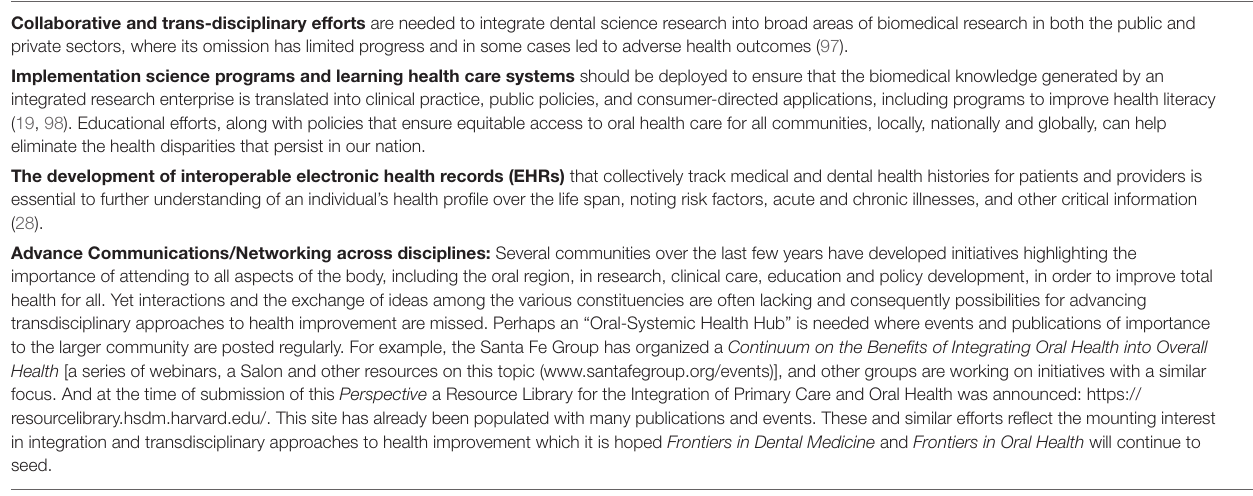
TABLE 2 | Approaches toward achieving integration of oral health within the context of total health. Collaborative and trans-disciplinary efforts are needed to integrate dental science research into broad areas of biomedical research in both the public and private sectors, where its omission has limited progress and in some cases led to adverse health outcomes (97). Implementation science programs and learning health care systems should be deployed to ensure that the biomedical knowledge generated by an integrated research enterprise is translated into clinical practice, public policies, and consumer-directed applications, including programs to improve health literacy (19, 98). Educational efforts, along with policies that ensure equitable access to oral health care for all communities, locally, nationally and globally, can help eliminate the health disparities that persist in our nation. The development of interoperable electronic health records (EHRs) that collectively track medical and dental health histories for patients and providers is essential to further understanding of an individual’s health profile over the life span, noting risk factors, acute and chronic illnesses, and other critical information